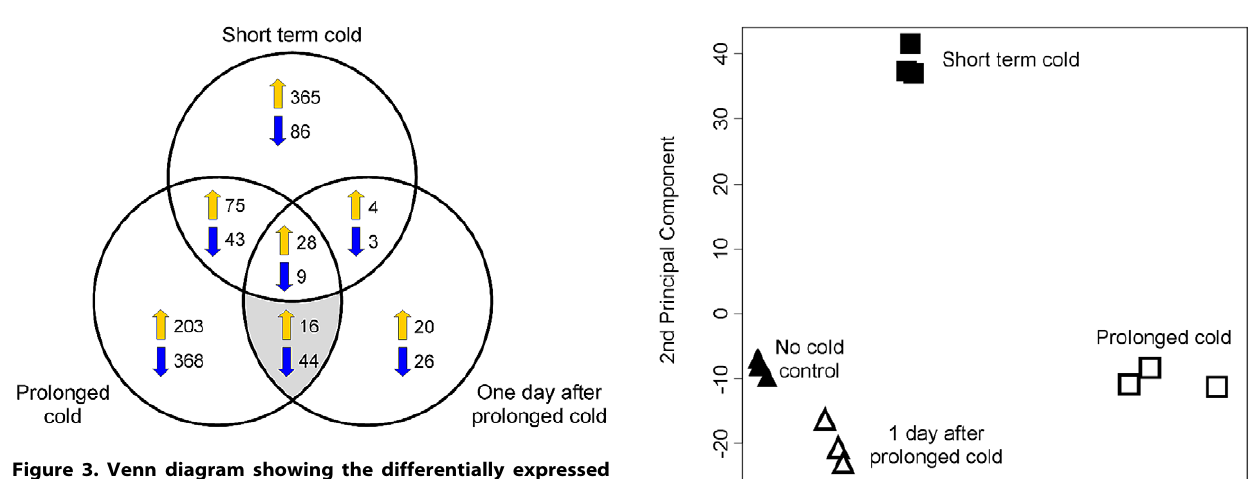
Figure 3. Venn diagram showing the differentially expressed contigs across the different treatments. A summary of the contigs that showed a two fold or greater change in transcript levels across the different treatments when compared to the control treatment (p , 0.1). Shaded area indicates contigs that were significantly changed in the samples treated with prolonged cold and one day after prolonged cold treatment, relative to the control.